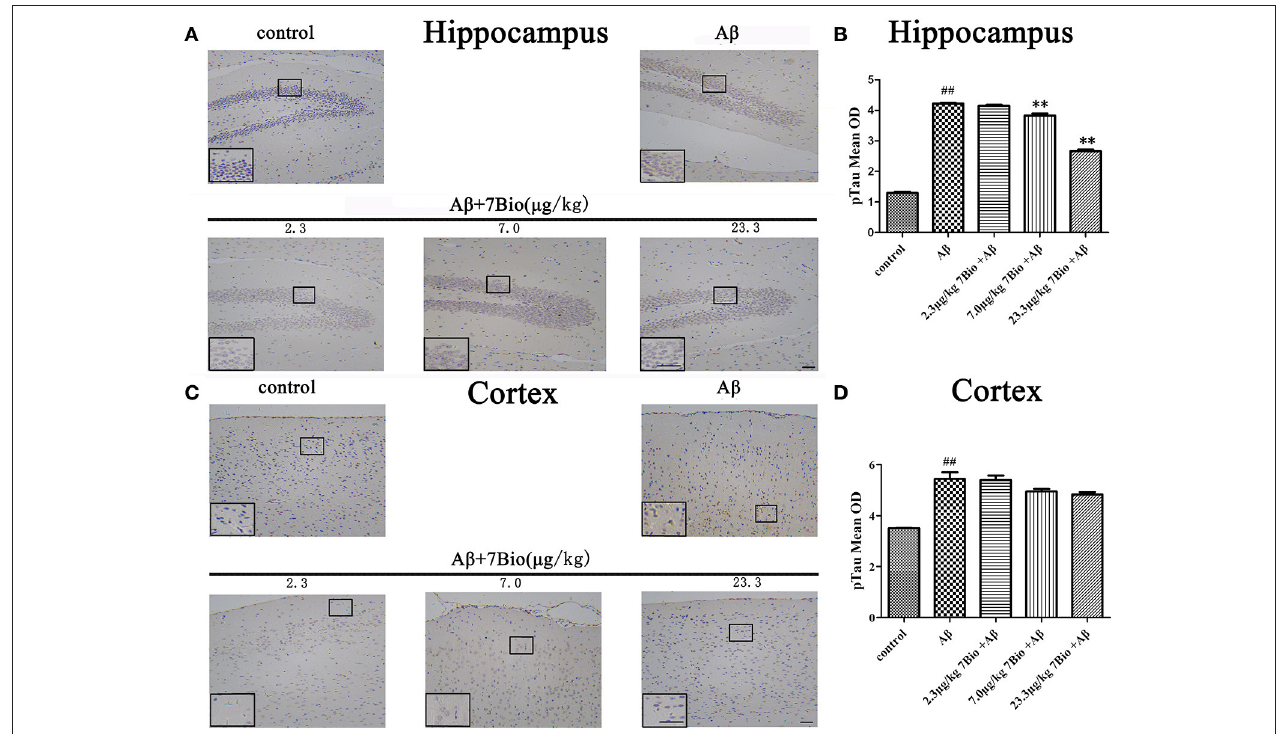
FIGURE 9 | 7Bio attenuates A β oligomer-induced increased of pTau in the hippocampal region of mice. (A) Representative figures of IHC staining of pTau in the hippocampal region in various groups as indicated. (B) Quantitative results showed that 7Bio decreased mean OD of pTau in the hippocampal region of mice. (C) Representative figures of IHC staining of pTau in the cortical region in various groups as indicated. (D) Quantitative results showed that A β oligomer-induced increased mean OD of pTau in the cortical region of mice. Data represent the mean ± SD ( n = 3); ## p < 0.01 vs. control group, ** p < 0.01 vs. A β group (one-way ANOVA and Tukey’s test). Scale bar: 30 µ